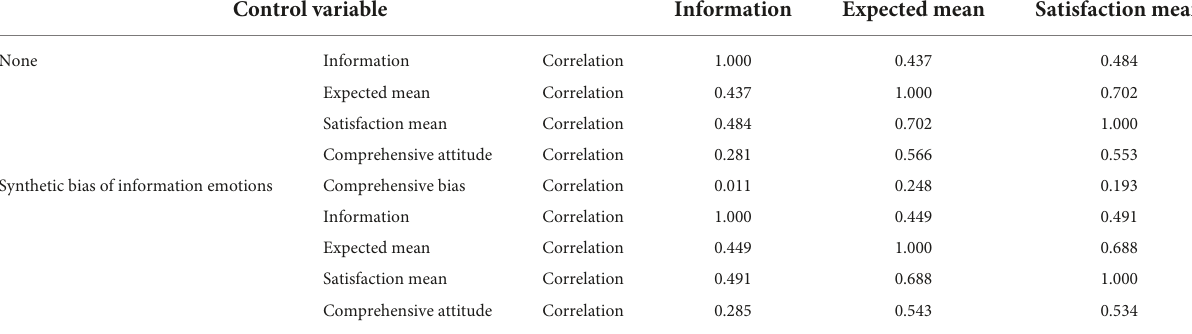
TABLE 3 Partial correlation analysis of sentiment synthesis bias.